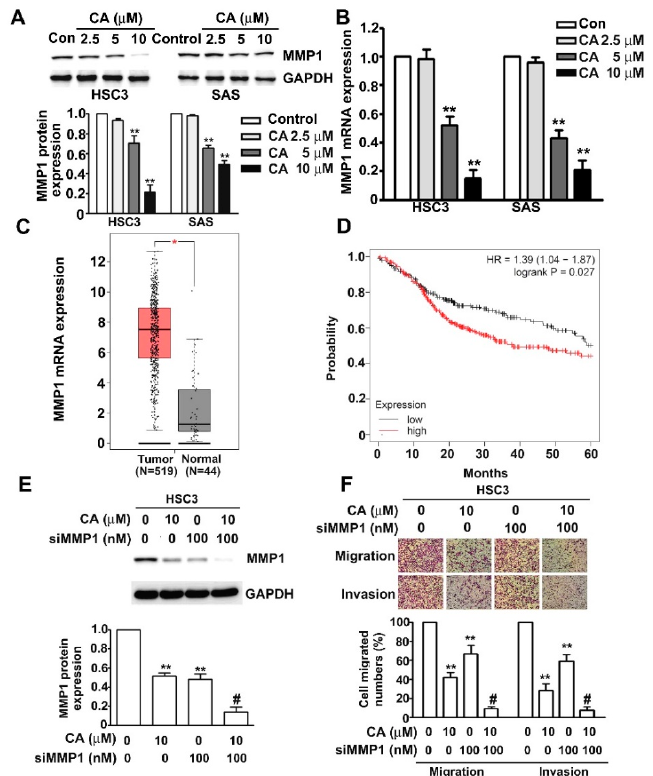
Figure 4. Effect of CA on MMP1 expression and cell invasion in human HSC3 and SAS OSCC cells. ( A , B ) Human HSC3 and SAS cells were treated with various concentrations of CA (0, 2.5, 5, 10 or 20 µ M) for 24 h, after which the protein and mRNA expression of MMP1 was measured via immunoblotting and qRT-PCR analysis. ( C ) MMP1 mRNA expression in the matched OSCC tissues and normal tissues was validated from the GEPIA databases. T: Tumour tissue ( n = 519); N: Normal tissue ( n = 44). *, p < 0.05 versus normal tissue. ( D ) The red line indicates high MMP1 expression, and the black line indicates low MMP1 expression. ( E , F ) Human HSC3 cells were treated with CA (10 µ M), siMMP1 (100 nM) or CA (10 µ M) plus siMMP1 (100 nM); then, MMP1 protein expression, migration and invasion were measured. GAPDH as a protein-loading control. **, p < 0.01 versus control (line 1), #, p < 0.05 vs. CA (line 2) or siMMP1 (line 3). Control: untreated cells. Scale bars: 50 µ